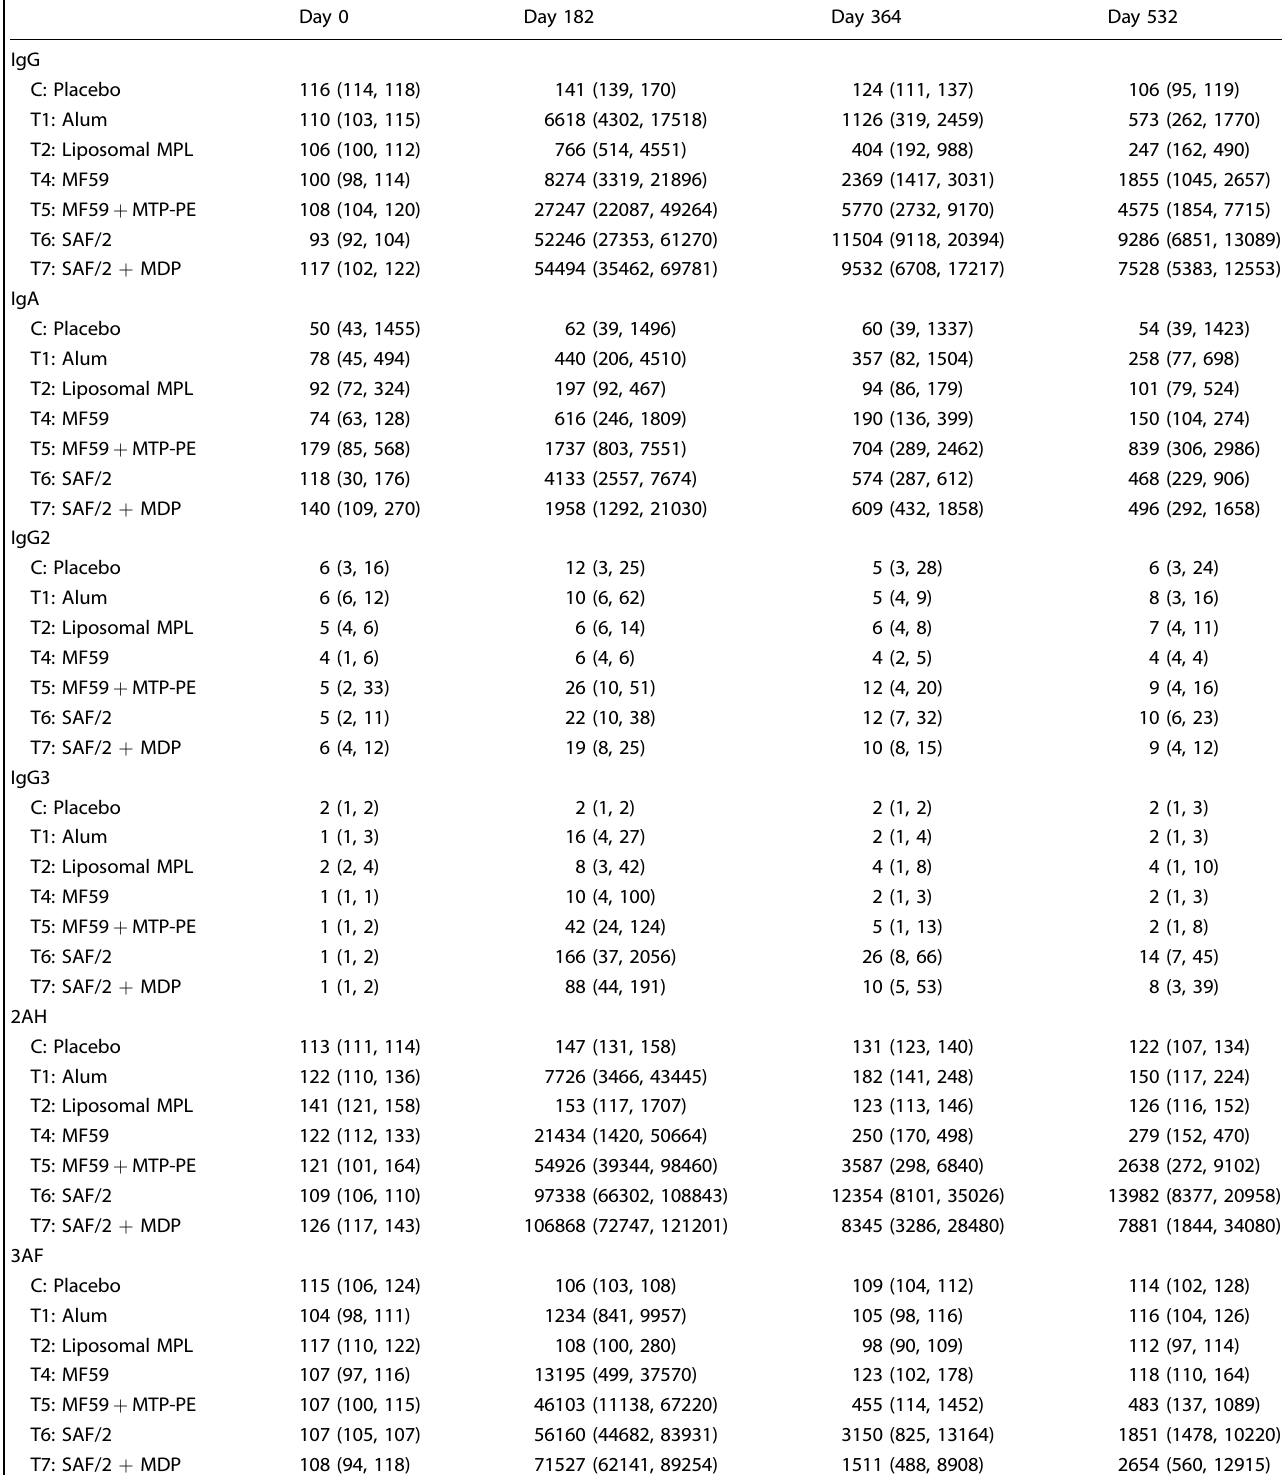
Table 2. SF-2 gp120 Binding antibody response summary.